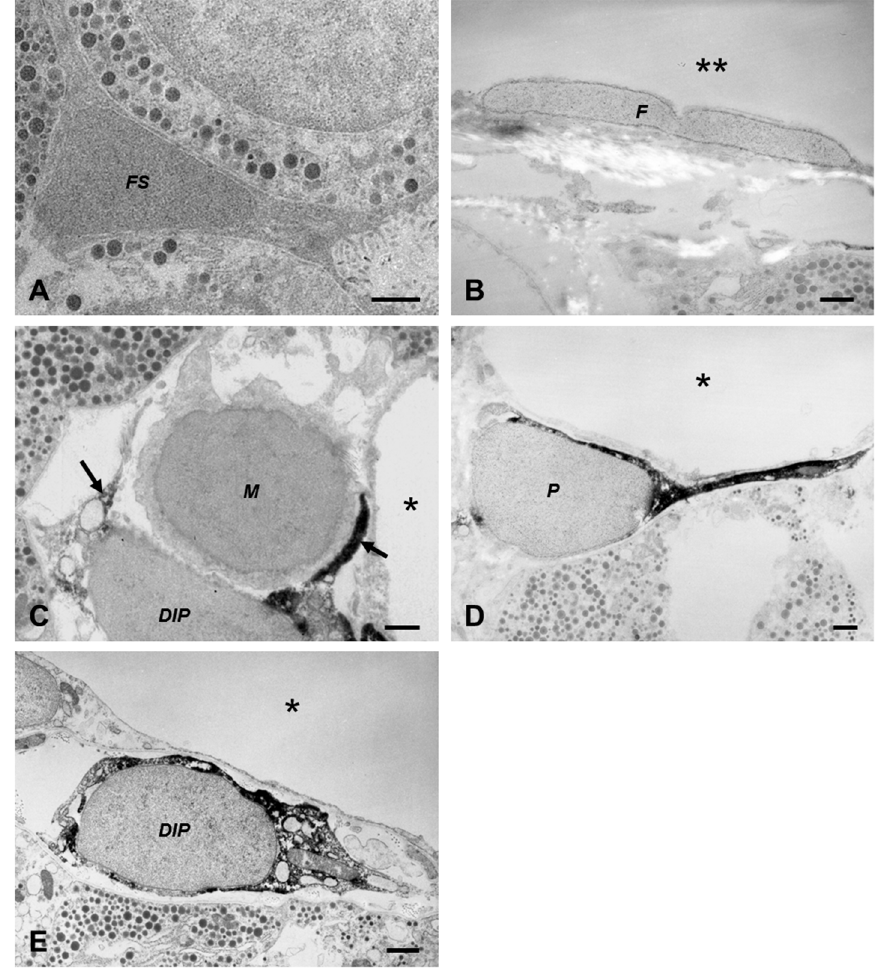
Figure 2. Desmin immunoelectron micrographs of nonhormone-producing cells in the rat anterior pituitary gland ( A – E ). A black positive signal of desmin is visible in pericytes and novel desmin- immunopositive perivascular cells, confirming the results from light microscopy: folliculostellate cell ( FS in A ); fibroblast at pituitary capsule ( F in B ); macrophage ( M in C ); pericyte ( P in D ); novel desmin-immunopositive perivascular cell ( DIP in C , E ); area outside the gland (double asterisks in B ); capillaries (asterisks in C – E ); cytoplasmic process of adjacent novel desmin-immunopositive perivascular cell (arrow in C ). Bars 1 µm.